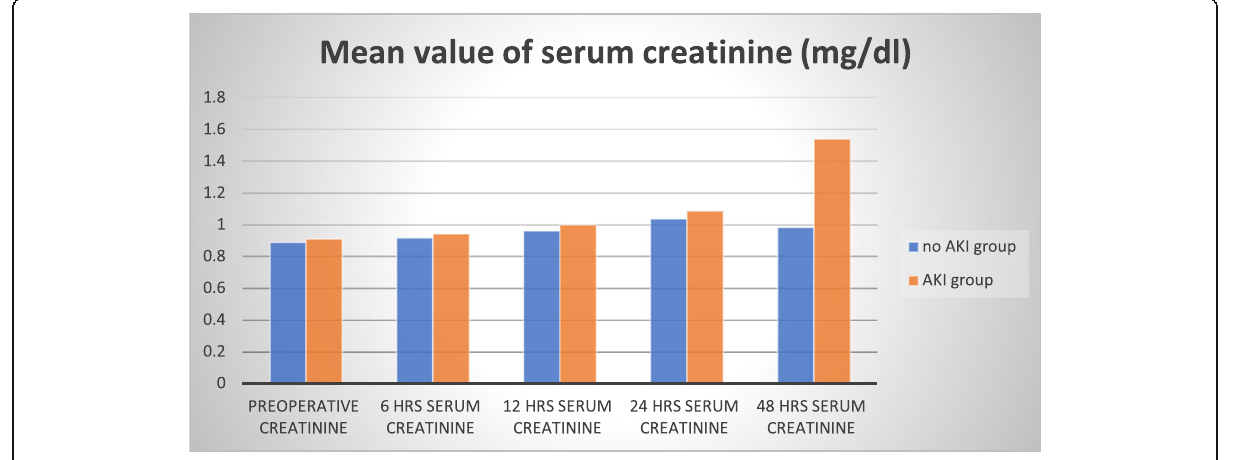
Fig. 1 Mean value of serum creatinine in both groups